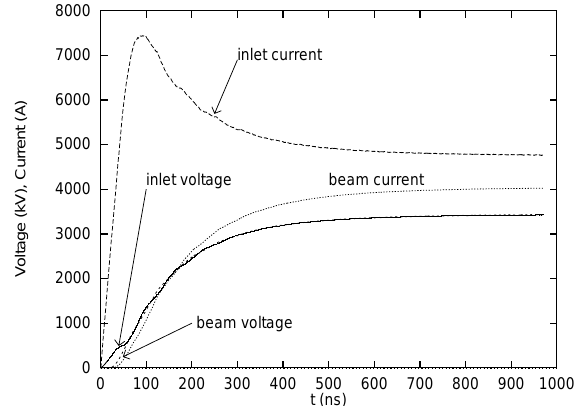
FIG. 4. Azimuthal variation of B u at different z positions (in cm), at a radius of 134 cm. The AK gap is at u (cid:1) 0 , z (cid:1) 0